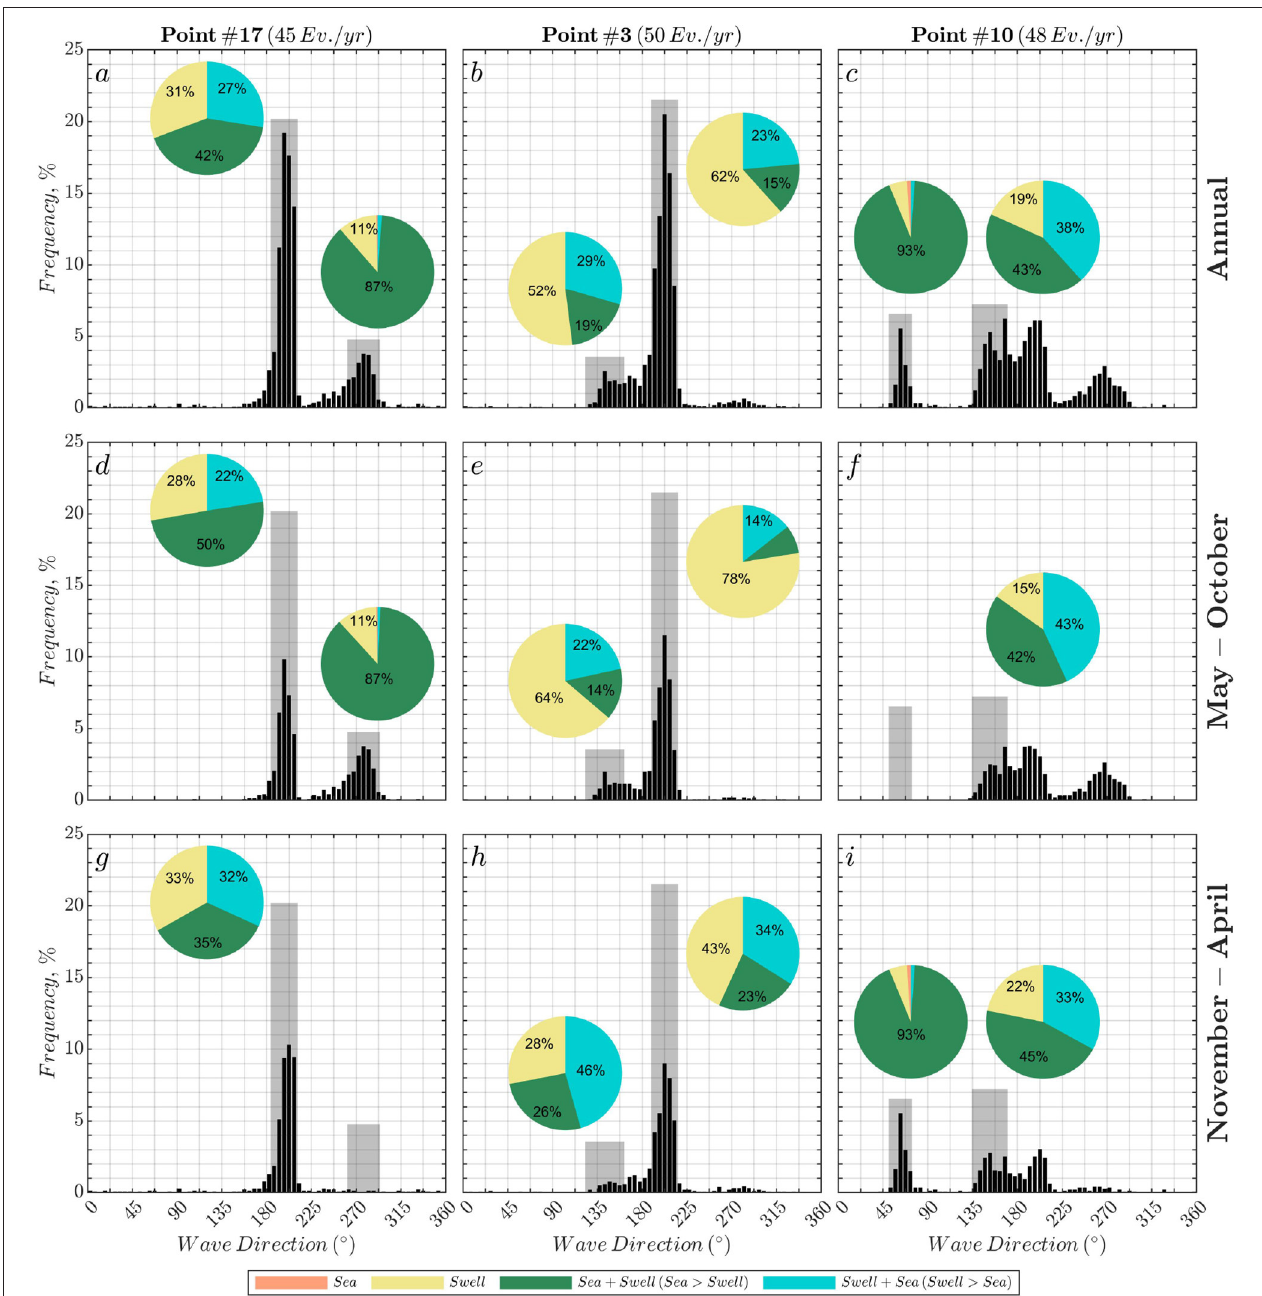
FIGURE 3 | Histograms of wave direction (in nautical convention) registered at the three points selected as being representative (point #17 in the first column ( a,d,g ), #3 in the second ( b,e,h ), and #10 in the third) ( c,f,i ). The first row shows the annual histograms ( a,b,c ), May-October histograms are shown in the second row ( d,e,f ) and November-April histograms are in the last row ( g,h,i ). Each pie chart indicates the spectral separation by type of wave produced by WaveWatch III model [pure sea ( H s of swell = 0), pure swell ( H s of sea = 0), sea + swell dominated by sea ( H s of sea > H s of swell) and swell + sea dominated by swell ( H s of swell > H s of sea)] corresponding to each wave component identified (grey shadows).